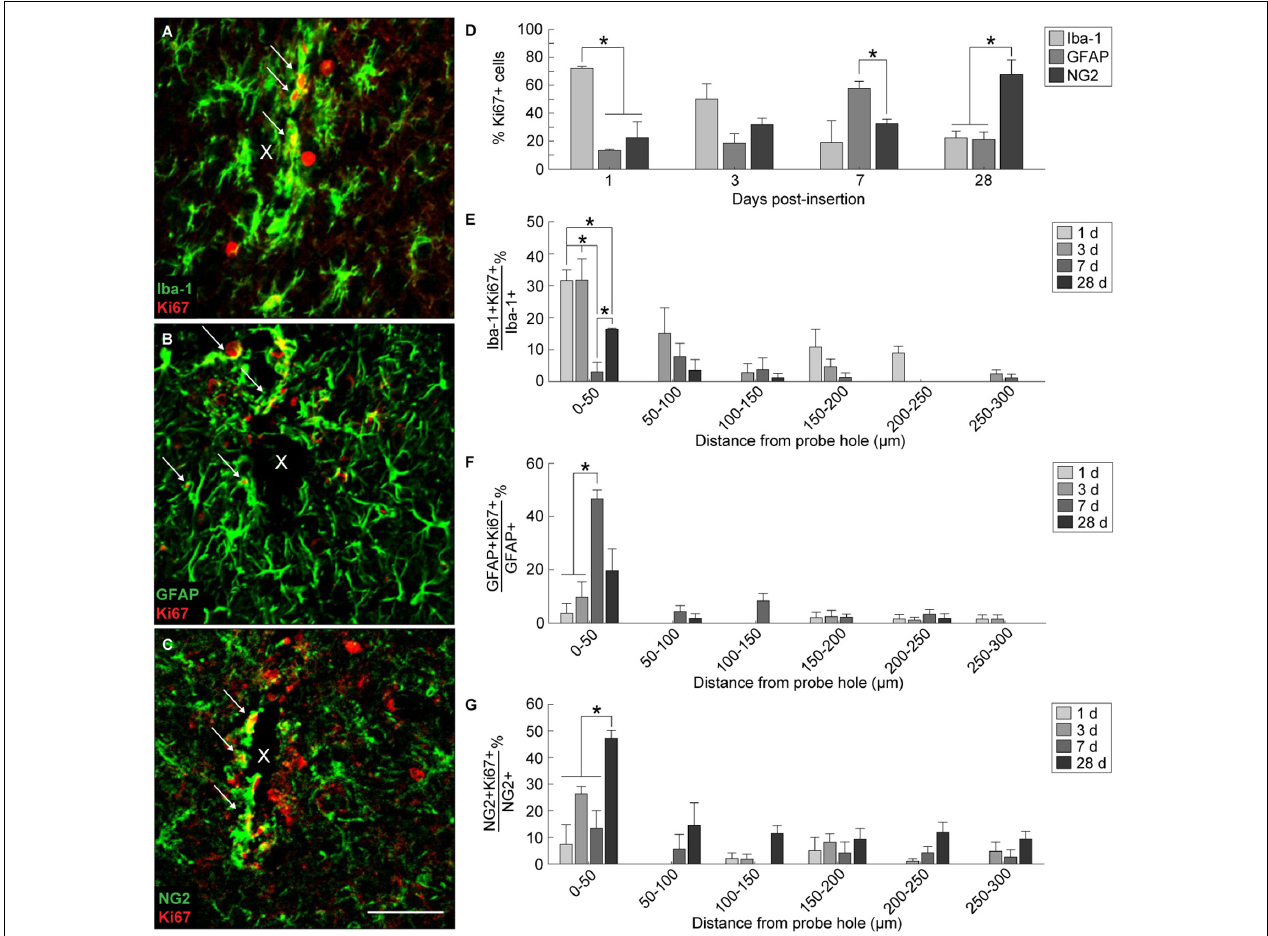
FIGURE 4 | Tracking proliferation of glial cells around an implanted microelectrode array. Microglia, astrocytes, and NG2 glia demonstrate distinct temporal patterns of proliferation following device insertion. Additionally, glial proliferation occurs most prominently at the site of insertion (0–50 µ m distance from probe hole). Representative immunohistochemical stain for Iba-1+ (A) , GFAP+ (B) , and NG2+ (C) cells that express the Ki67+ proliferation marker. White arrows denote co-localized cells and indicate glial proliferation. Center of the probe hole is denoted by a white “x.” Scale bar = 50 µ m. (D) Percent of Ki67+ cells within 300 µ